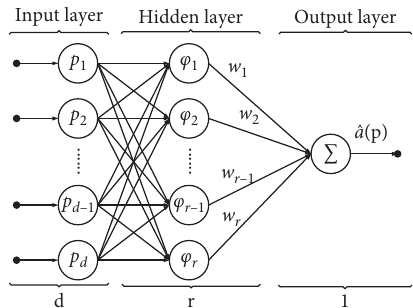
Figure 2: The structure of the designed RBF